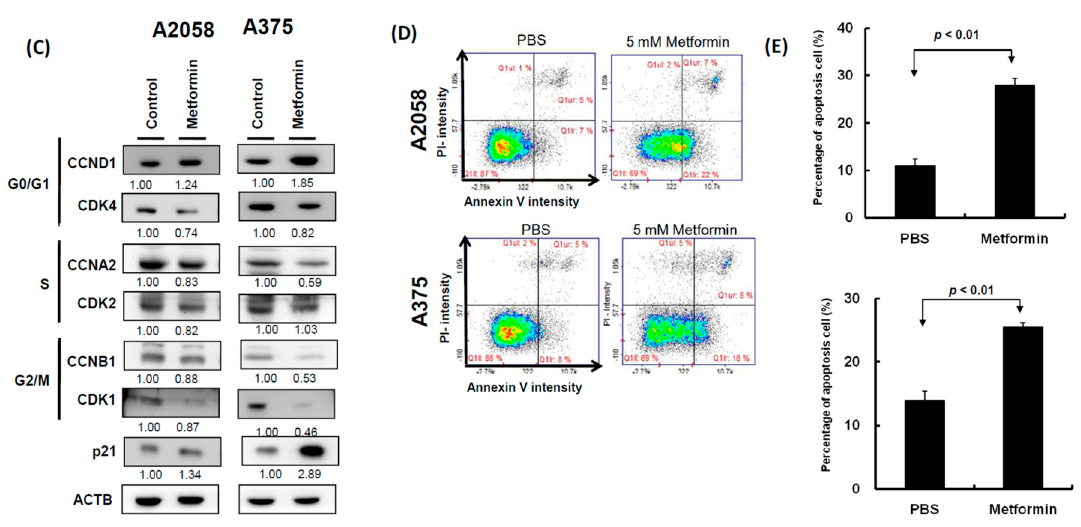
Figure 2. Metformin suppressed melanoma cell growth by impairing cell cycle progression and inducing apoptosis. ( A ) and ( B ) After treatment with 5 mM metformin for three days, cell cycles of A2058 and A375 cells were examined using image-flow cytometry assay , and the graph depicts the quantification for each phase. ( C ) Expression levels of cell cycle-relative genes were examined in A2058 and A375 cells treated with or without metformin using the Western blot approach. ( D ) A2058 and A375 cells were treated with or without metformin (5 mM) for three days and stained with propidium iodide; then, cell apoptosis was assessed through image-flow cytometry analysis. ( E ) Percentages of apoptotic cells of A2058 and A375 cells with or without metformin treatment are presented. Data are presented as the mean ± standard deviation of three independent experiments.